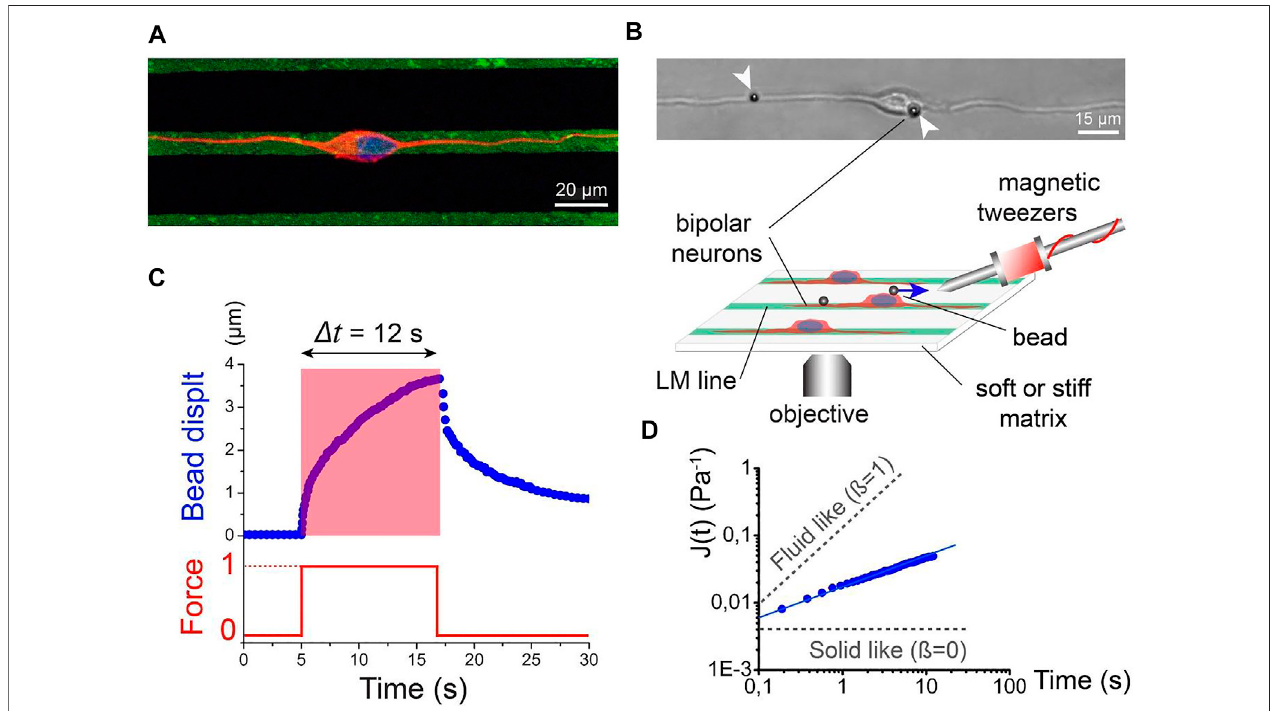
FIGURE 5 | Active rheology of cortical neuronal microcompartments. (A) Immuno fl uorescence micrograph of nucleus (blue) and microtubules (red) of a bipolar neuron attached to laminin lines (green). Scale bar: 20 microns. (B) Schematic of magnetic tweezer rheological set up. Bipolar morphology of cortical neurons was achieved by growth on laminar strips. A bipolar neuron with magnetic beads attached to the membrane is depicted by the DIC image. Scale bar: 15 microns. (C) Bead displacement as a function of time (blue line) in response to a step force input (red line). (D) Logarithmic of creep compliance J(t) as a function of time. The slope of thegraph(beta)depictssolid-likeandliquid-likebehavior.FigurefromGrevesse,T.,etal.Oppositerheologicalpropertiesofneuronalmicrocompartmentspredictaxonal vulnerabilityinbraininjury. SciRep 5,